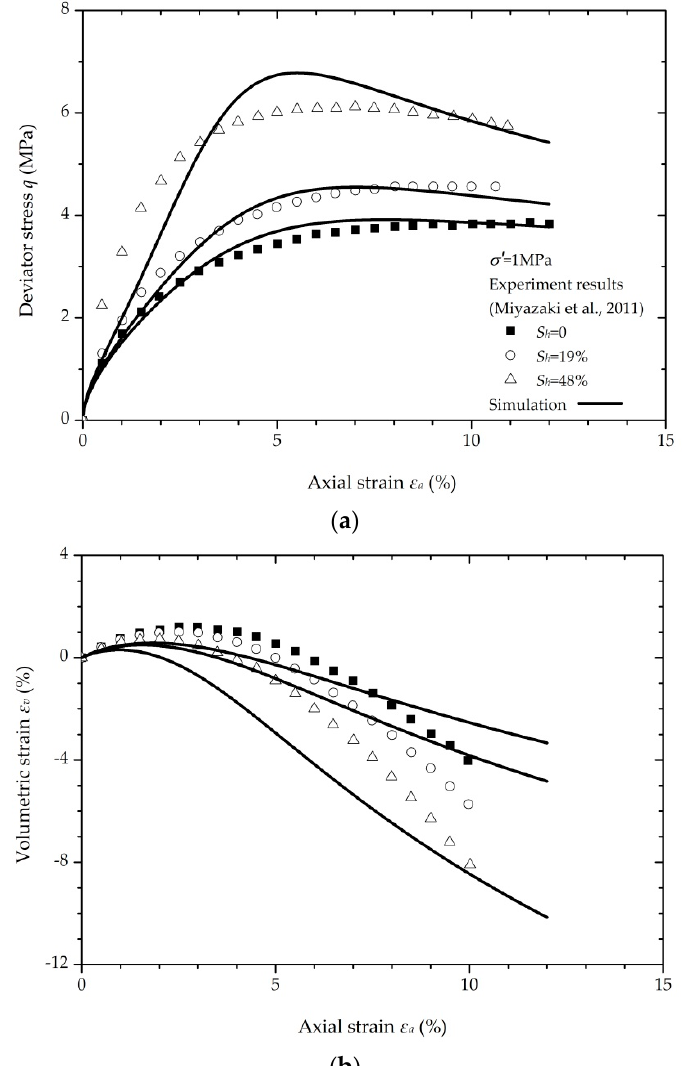
Figure 9. Comparison between the drained triaxial test results and the model predictions for MHBS synthesized from No. 8 silica sand: ( a ) relationship between deviator stress q and axial strain ε a ; ( b ) relationship between volumetric strain ε v and axial strain ε a .